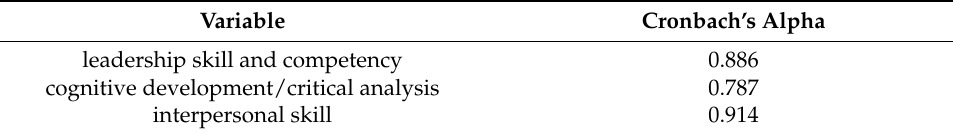
Table 2. Reliability statistic for the